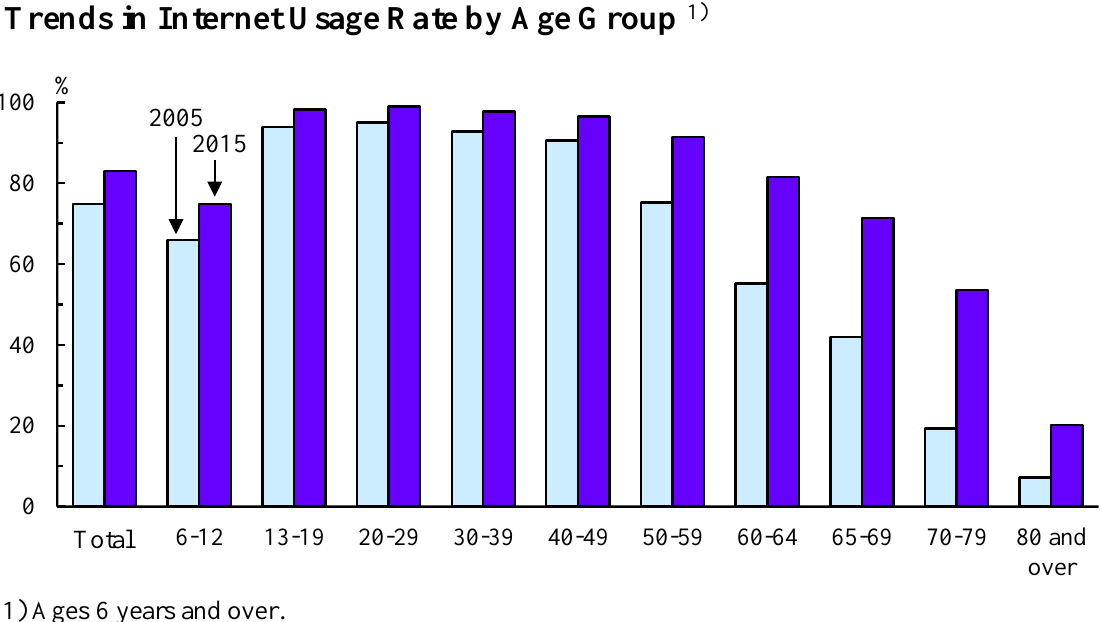
Trends in Internet Usage Rate by Age Group 1)